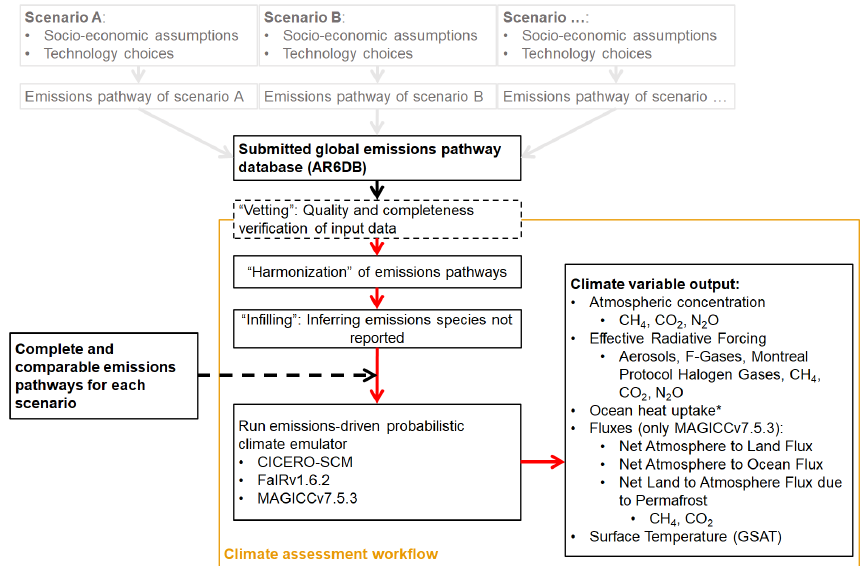
Figure 1. The steps of the “climate-assessment workflow”. Overview of climate-assessment processing steps applied in the Working Group III contribution to the IPCC Sixth Assessment Report. The asterisk is added in the figure to indicate that ocean heat uptake was provided only by FaIRv.1.6.2 and MAGICCv7.5.3 in